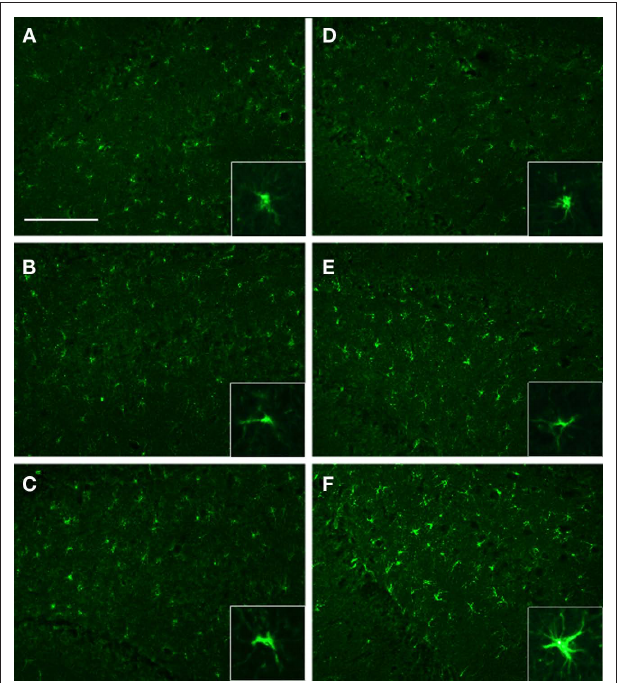
Figure 6 | The DCX immunoreactivity in selected brain regions of animals in the various experimental groups. Frozen coronal sections containing the DHC and the VHC were cut and processed for immunohistochemistry using a DCX antibody. DHC of (A) NH-S, (B) NH-I,